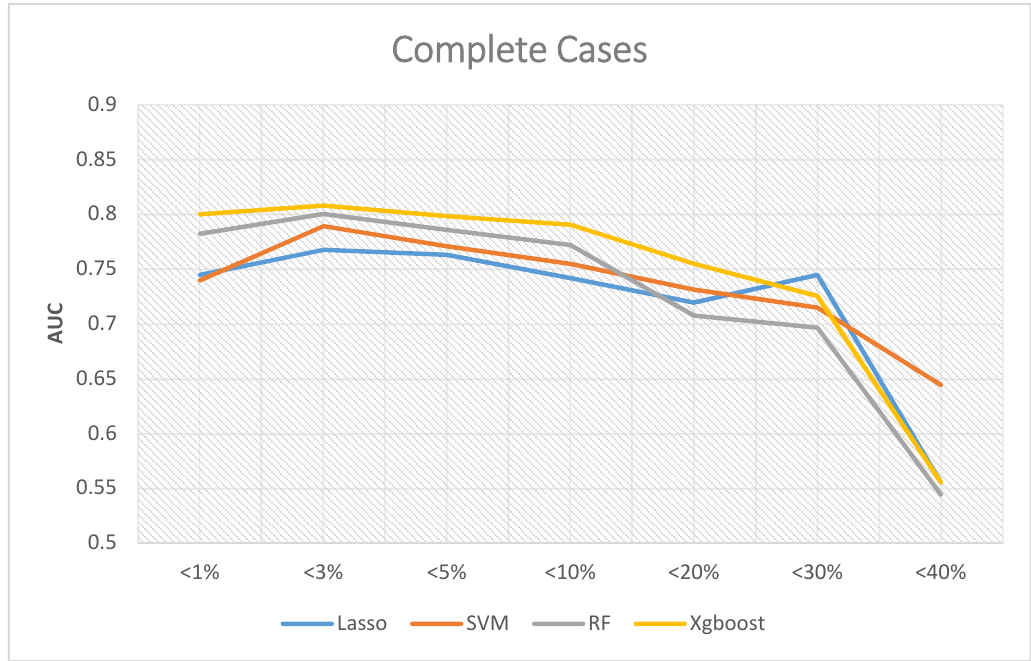
Figure 4. AUC for complete cases.